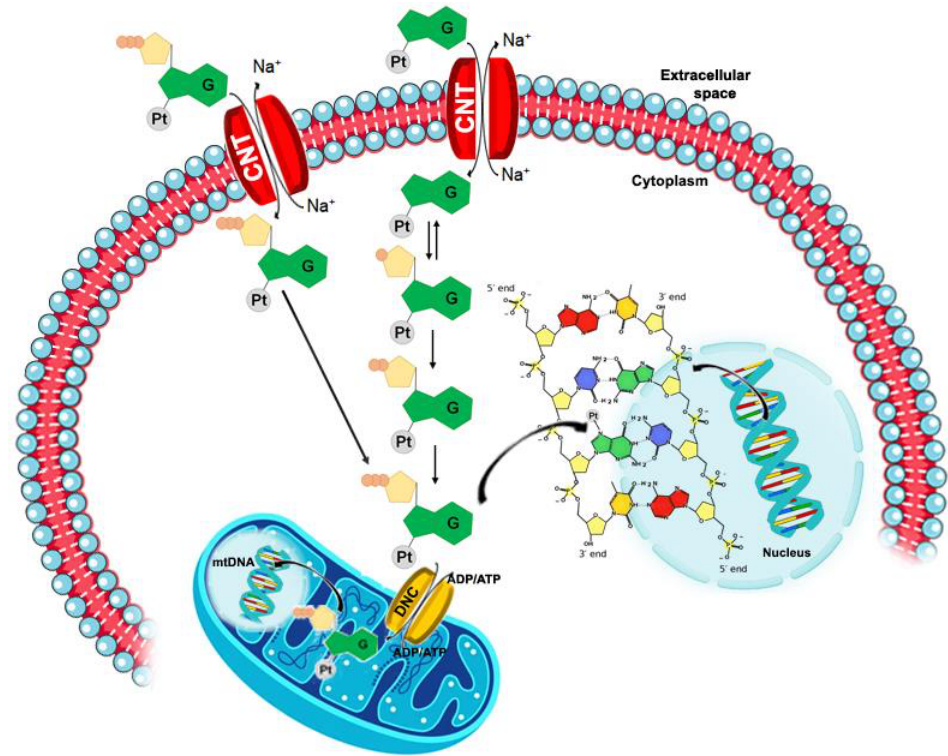
Figure 13. Proposed mechanism of action of platinated nucleos(t)ides.